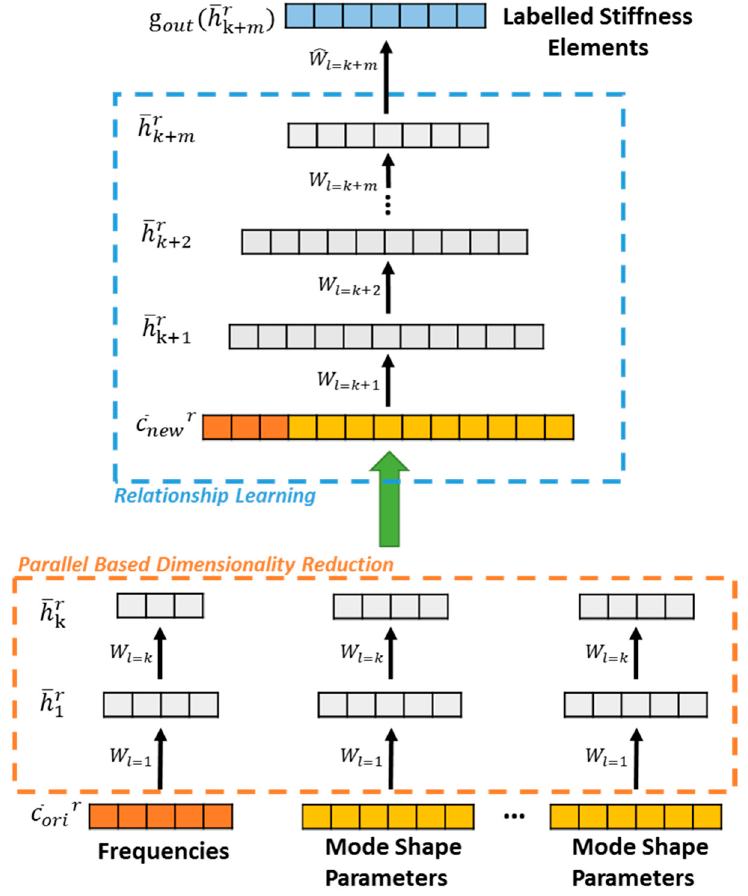
Figure 2. Proposed parallel auto-encoder model.